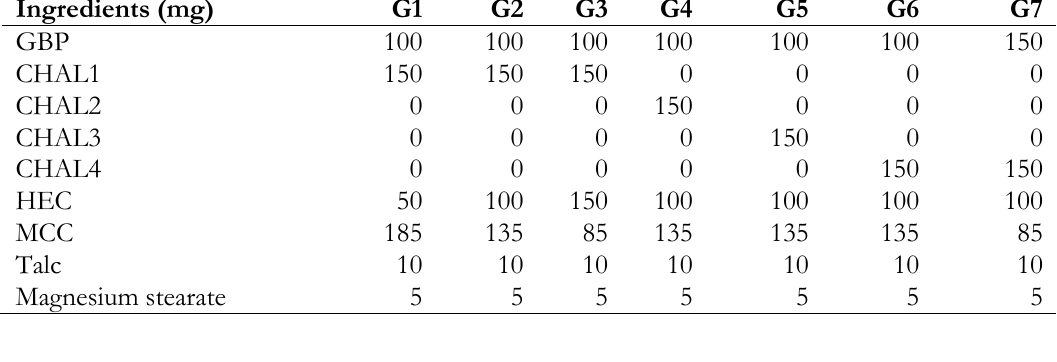
Table I Composition of hydrogel matrix tablets Ingredients (mg)